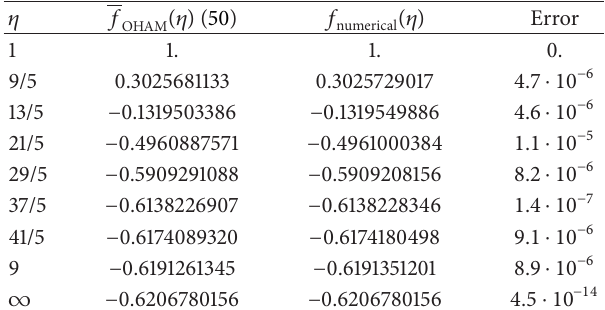
Table 4: Comparison between the second expression of the first- order approximate solutions 𝑓(𝜂) given by (50) obtained by OHAM and numerical results for 𝛾 = 1 and 𝑆 = −1 (error = |𝑓 (𝜂)| 𝑓 numerical